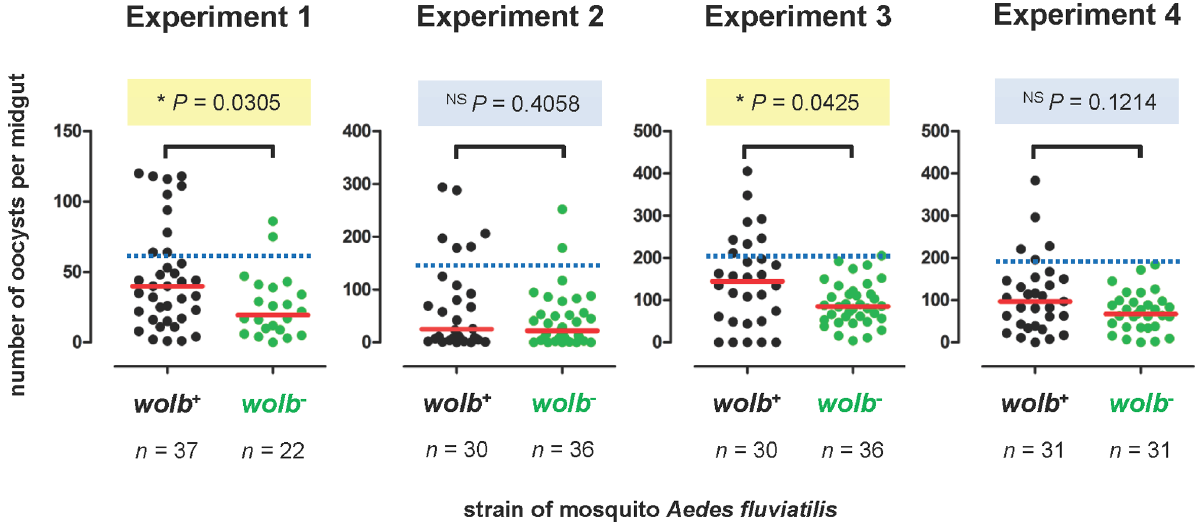
Figure 5. w Flu does not inhibit Plasmodium in Ae.fluviatilis . Graphs showing the number of oocyst stage malaria parasites observed on the midguts of wildtype ( wolb + ) and antibiotic-treated ( wolb 2 ) strains of the mosquito Ae. fluviatilis 7 days after infection with the avian malaria parasite P. gallinaceum . Each circle represents a single midgut from an adult female mosquito, while the red horizontal bars indicate the median number of oocysts per midgut. The data shown are from four independent biological replicates (i.e., four different generations, after antibiotic treatment, of the laboratory colony of Ae. fluviatilis ). The numbers of oocysts per midgut were compared separately for each biological replicate (i.e., generation) using a Mann-Whitney U test. *=significantly different; NS=not significantly different. The dashed blue lines indicate the threshold used in Figure 6 to classify mosquitoes as having either relatively low or high P. gallinaceum oocyst infections.